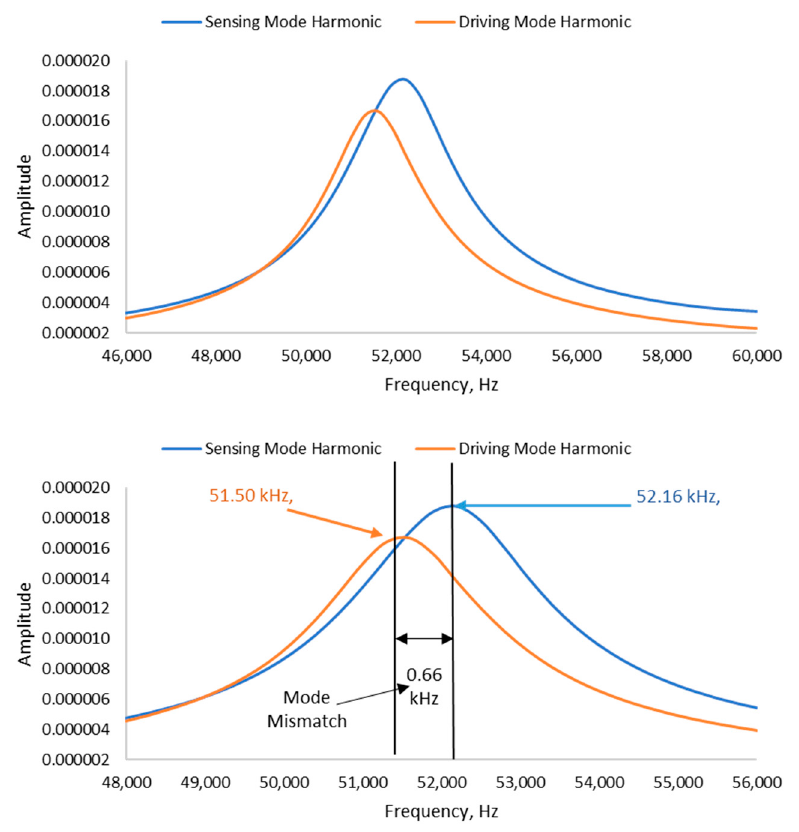
Figure 6. A harmonic response for the amplitude-frequency response. Table 2. Comparison with similar vibrating ring gyroscope